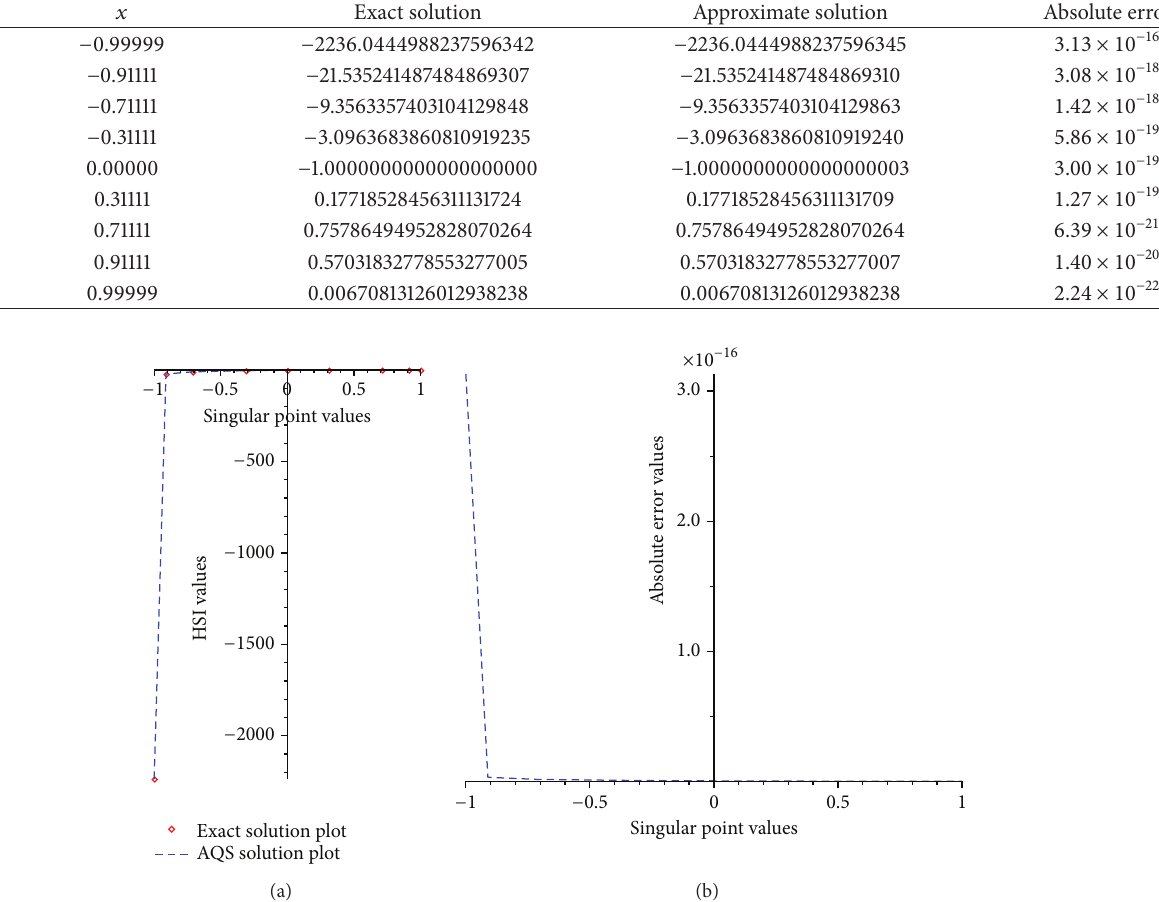
Figure 1: (a) Exact and AQS solutions when 𝑁 = 2 and ℎ(𝑡) = 2𝑡 2 − 3𝑡 + 5 and (b) absolute error between exact and AQS solution when 𝑁 = 2 and ℎ(𝑡) = 2𝑡 2 − 3𝑡 + 5